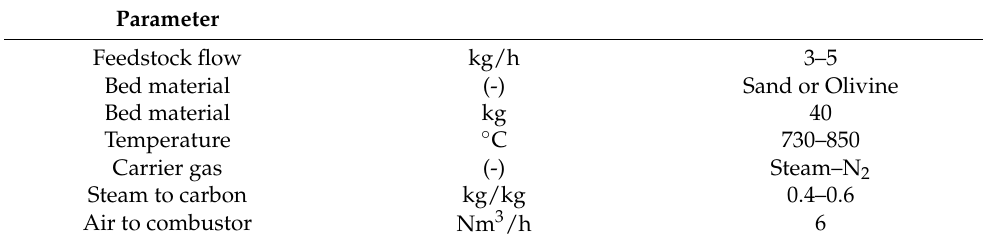
Table 2. Average settings of the MILENA gasifier.